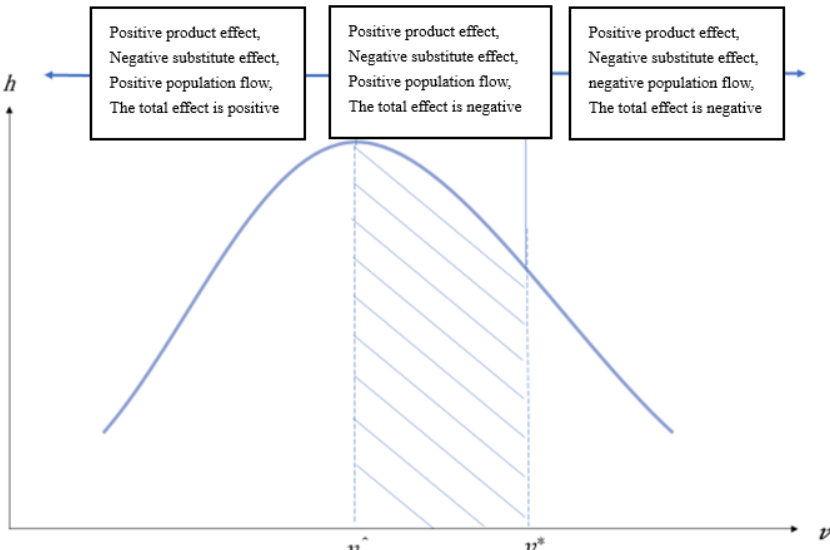
Figure 4. Transportation infrastructure, population flow, and health. Note: v is the proportion of public expenditure on transportation and h is health capital.